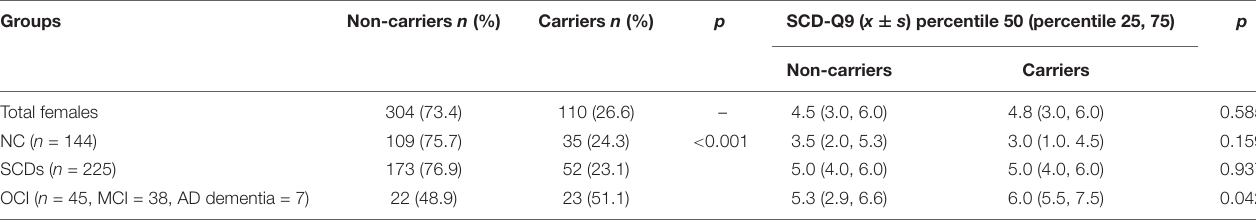
TABLE 4 | Distribution of APOE ε 4 and SCD-Q9 scores of carriers and non-carriers in NC, SCDs, and OCI groups in females.